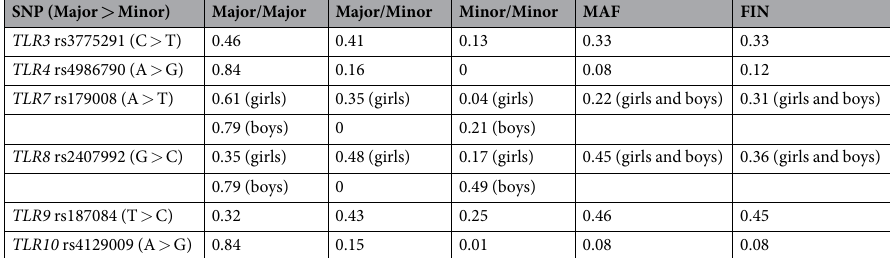
Table 1. Genotypes and minor allele frequencies of genes encoding toll-like receptors 3, 4, 7, 8, 9, and 10 in 135 children hospitalised for bronchiolitis and in the Finnish population. MAF = minor allele frequency, FIN = Finnish MAFs as in ref. 20. N = 135 for TLR3 , TLR4 , TLR7 , and TLR8 ; N = 134 for TLR9 and TLR10